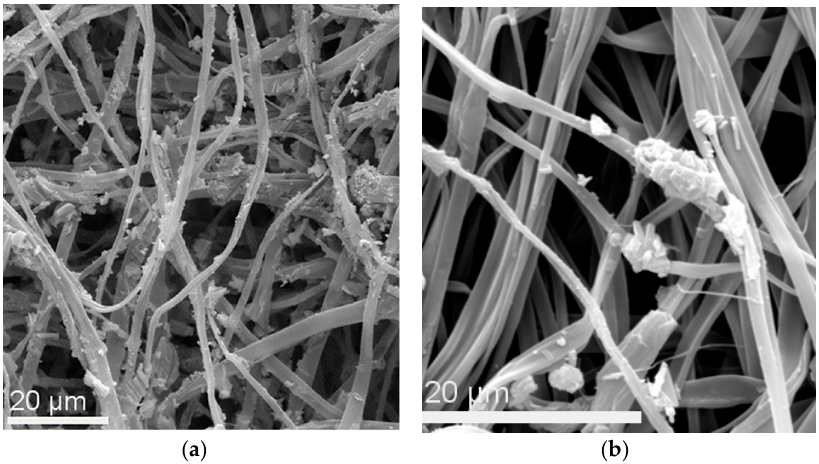
Figure 11. ( a ) SEM images of the magnetically modified regenerated cellulose fibers decorated with MIONP-OAOA NPs (inner layer). ( b ) Magnetically modified, regenerated cellulose fibers (nanocomposite sandwiched structure).